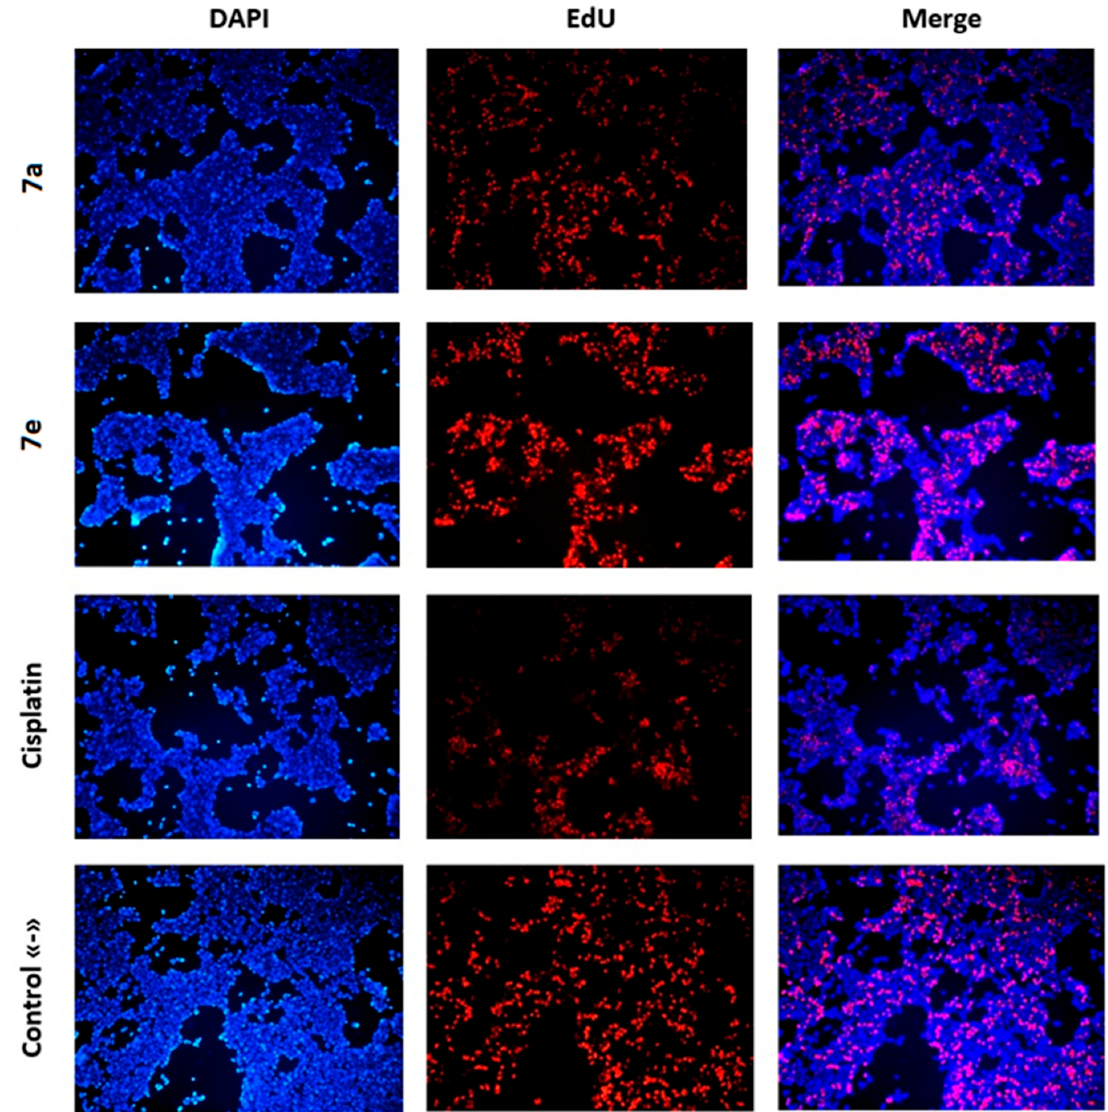
Figure 6. Assessment of DNA synthesis intensity in human embryonic kidney cell cultures of HEK- 293 line under the action of compounds 7a and 7e . Blue color stains the nuclei of all cells using DAPI dye, and red nuclei of cells with active DNA synthesis (EdU) , at 100× magnification .